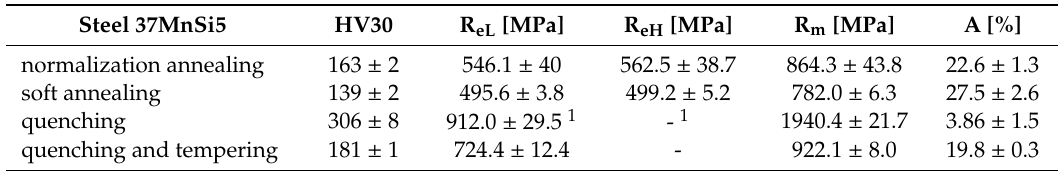
Table 6. Vickers hardness HV30, lower R eL and upper R eH yield strength, ultimate tensile strength R m , percentage elongation after fracture A.